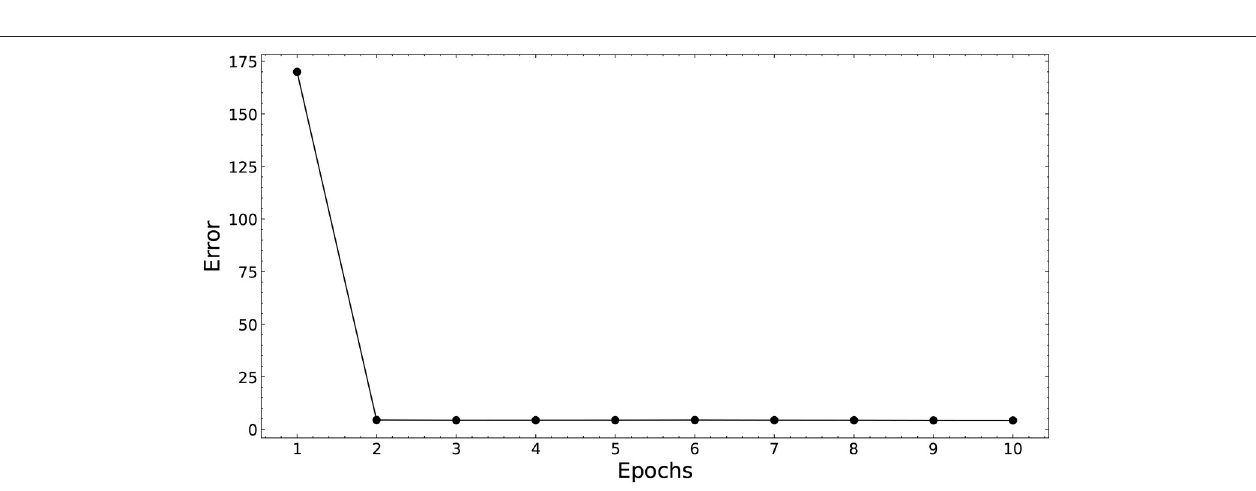
FIGURE 5 | Validation error of SSA-PNN. The plot shows the experimental results of validation with 10 epochs. The best validation performance was attained at epoch